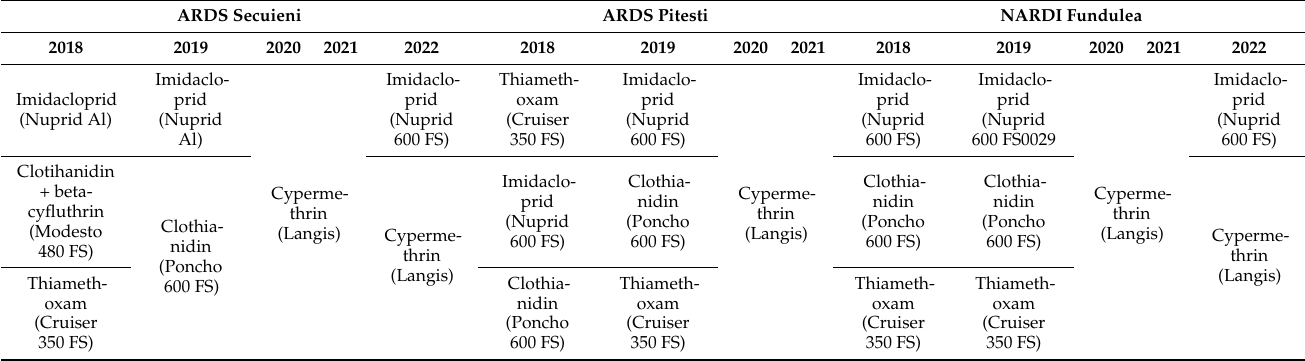
Table 3. Sunflower experimental